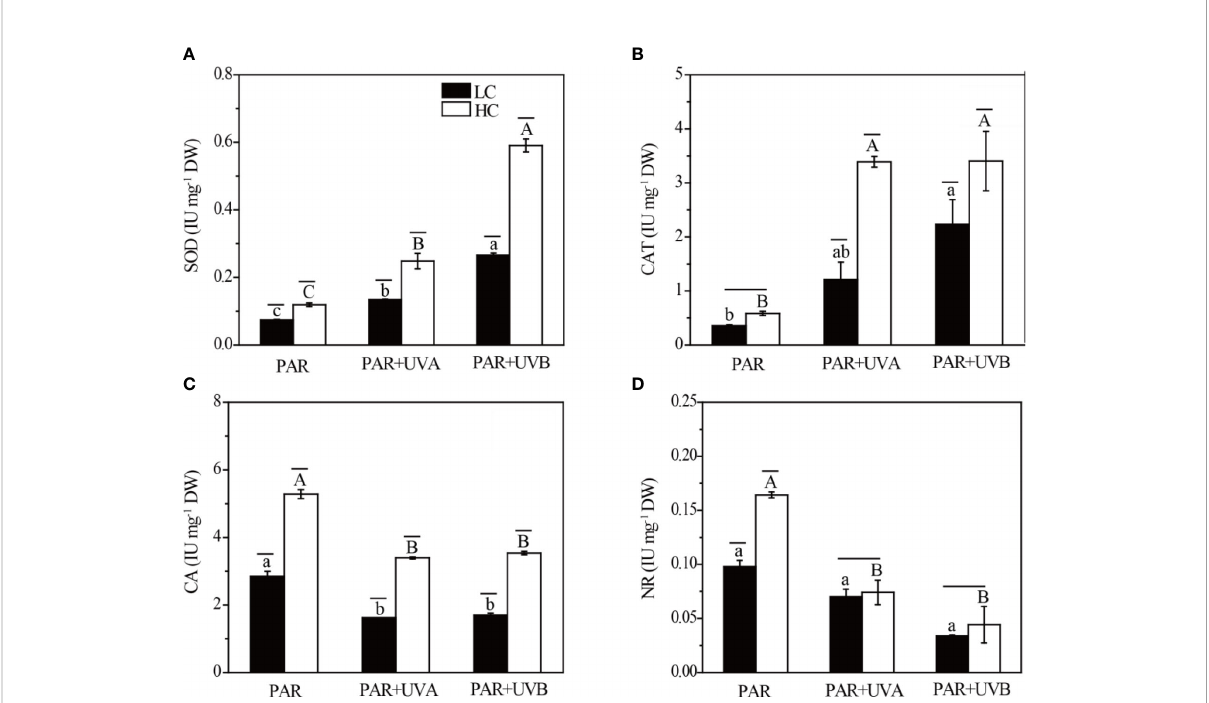
FIGURE 7 The activities of SOD (A) , CAT (B) , CA (C) and NR (D) of Rhodosorus sp. SCSIO-45730 treated under different p CO 2 levels and UVR. Short horizontal lines represent signi fi cant differences (P<0.05) among CO 2 treatments at the same UVR treatment, while long horizontal lines indicate insigni fi cant differences. Different lowercase letters represent signi fi cant differences (P<0.05) among UVR treatments under LC, and different capital letters indicate signi fi cant differences (P<0.05) among UVR treatments under